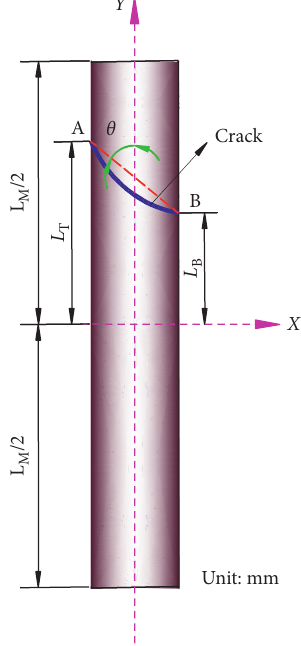
Figure 10: Schematic demonstration of crack location and evolution